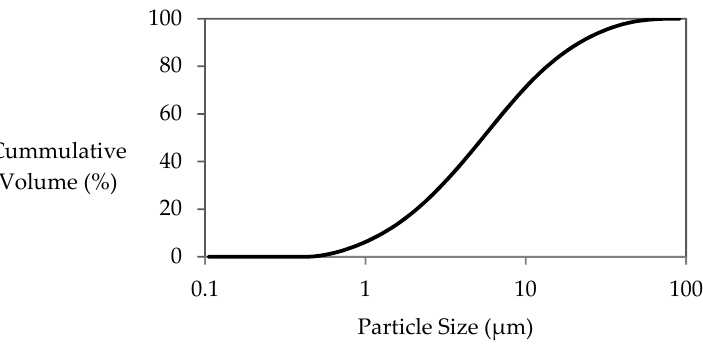
Figure 1. Particle Size Distribution of Fly Ash.